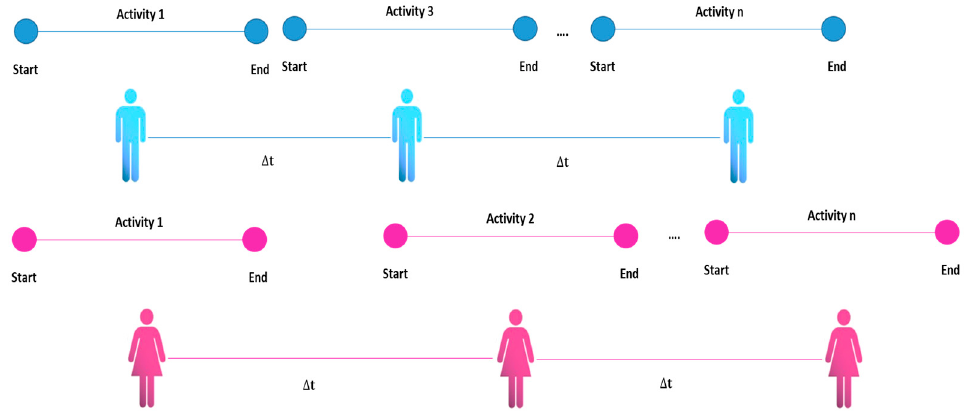
Figure 3. Interleaved activity representation.